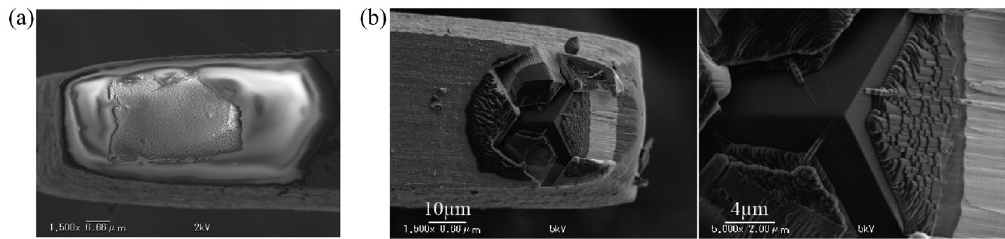
Figure 3. SEM image of the original diamond abrasive on the tip of the microcantilever ( a ). SEM image of the diamond abrasive fabricated by focused ion beam technique ( b ). The fabricating was performed twice, one was rough processing with an ion beam in a diameter of 500 nm and the other was precise processing with an ion beam in a diameter of 200 nm. The angle of the fabricated diamond is 90 degrees; this angle is formed by the sides and the triangular faces at the profile vertex.